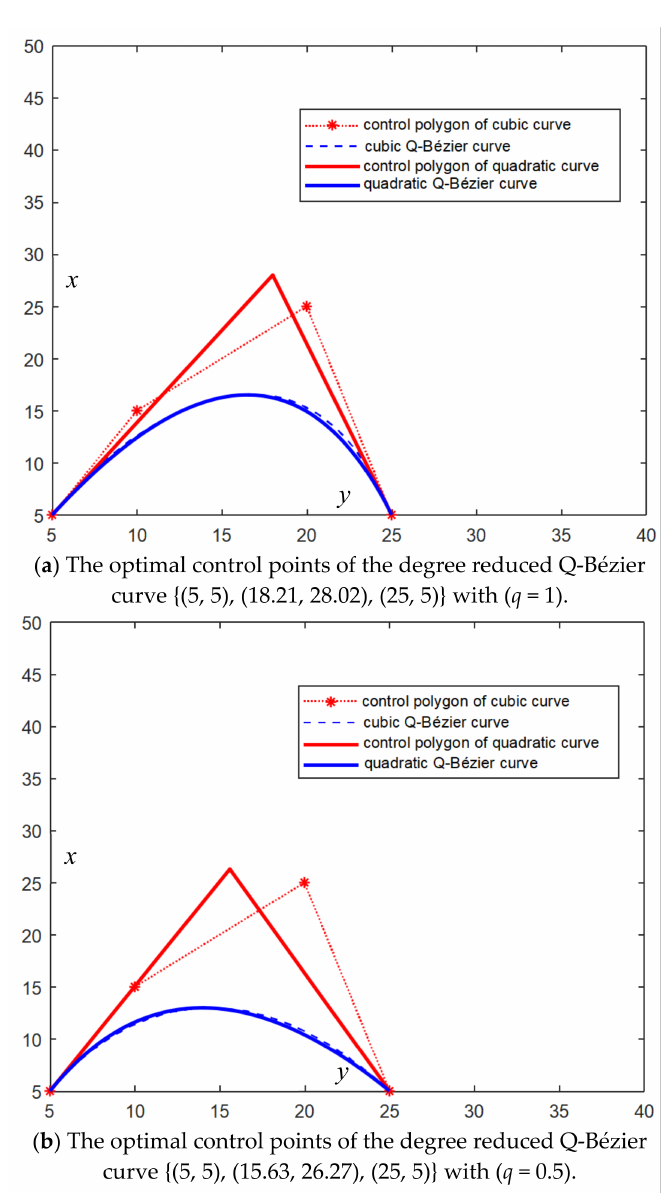
Figure 2. One-degree reduction of a cubic Q-B é zier curve with the shape parameter q = 1, 0.5. Example 2. Given the control points of a quartic Q-B é zier curve {T 0 = (5, 5), T 1 = (10, 20), T 2 = (20, 30) , T 3 = (25, 20), T 4 = (30, 5)}, the generated quartic Q-B é zier curve (blue dot line) and the approxi- mating cubic Q-B é zier curve (blue solid line) are shown in Figure 3a with q = 1. Another pair of curves with q = 0.5 are shown in Figure